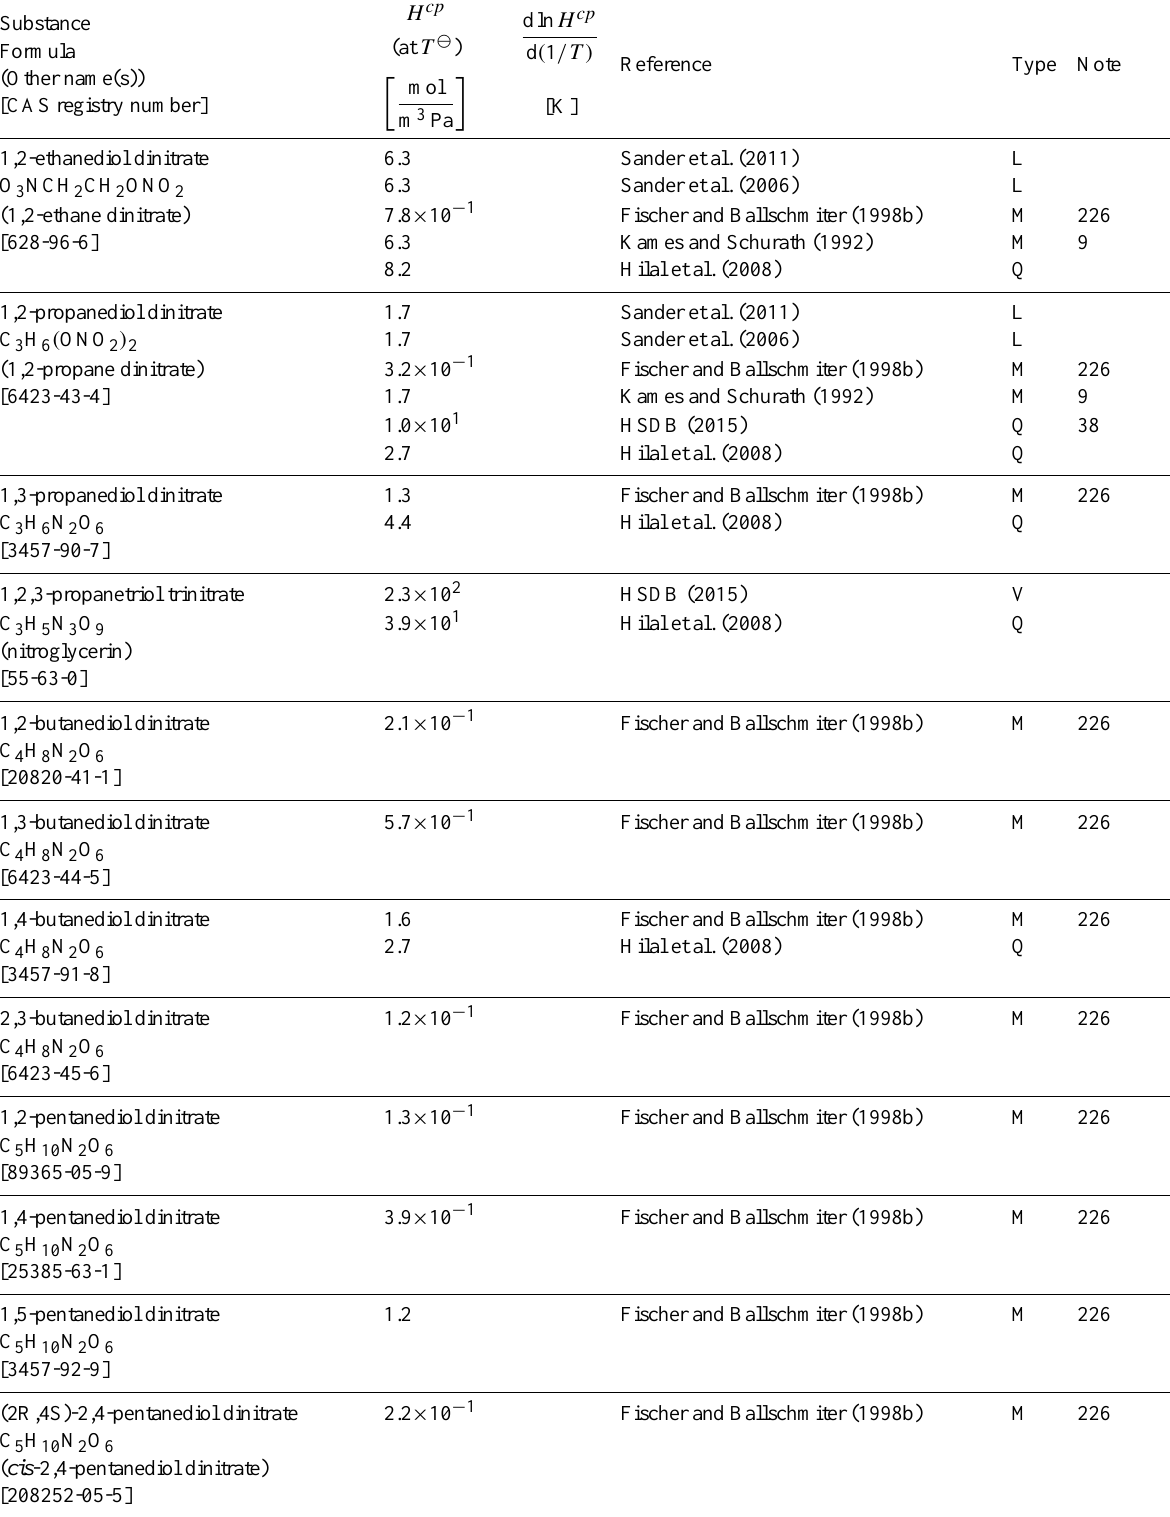
Table 6: Henry’s law constants for water as solvent